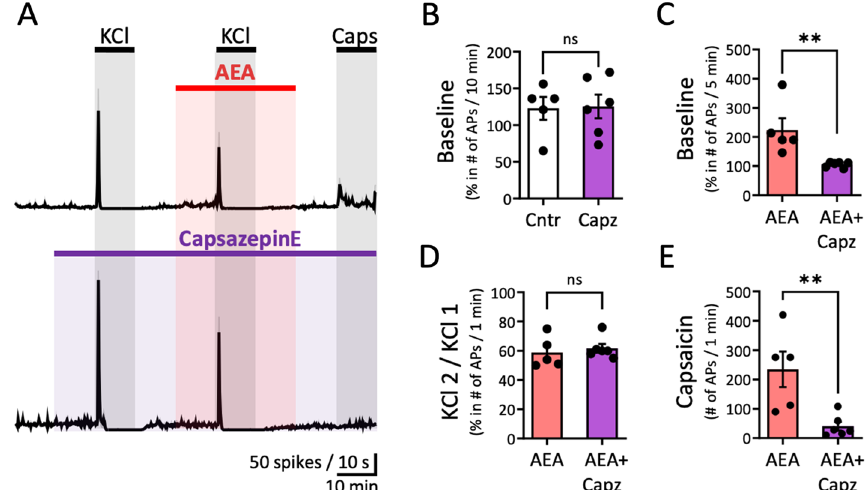
Fig. 7 AEA analgesia and its interaction with TRPV1 receptors. A Time courses of spike frequency (10‑s bin size) induced by APs recorded from the peripheral part of trigeminal nerve innervating rat meninges within the 1‑min active phase of the 2 nd KCl pulse in combination with 10 µM AEA or with the co‑application of 10 µM AEA and 20 µM capsazepine. Note the non‑significant changes in nociceptive firing during applications of 10 µM AEA and the combination of 10 µM AEA and 20 µM capsazepine. Notably, capsaicin‑induced firing decreased during the combined application of 10 µM AEA and 20 µM capsazepine. B No difference was observed between the APs ratio before and during 10 min capsazepine comparing to the Aps ratio of the same tine windows in the control condition. C The ratio of APs (before/during application of exogenous AEA, N 5) for the 5‑min = baseline returned to the control baseline level in presence of capsazepine ( N 6, Mann Whitney U test, ** 0.004). D The percentage between = = the number of APs induced by the 1 st and 2 nd KCl pulse for the 1‑min within AEA was not affected by the application of both 10 µM AEA and 20 µM capsazepine. E The number of APs during the 1‑min active phase of 1 µM Capsaicin when also AEA was applied ( N 5) was reduced after = application of both 10 µM AEA and 20 µM capsazepine ( N 6, Mann Whitney U test, ** = =